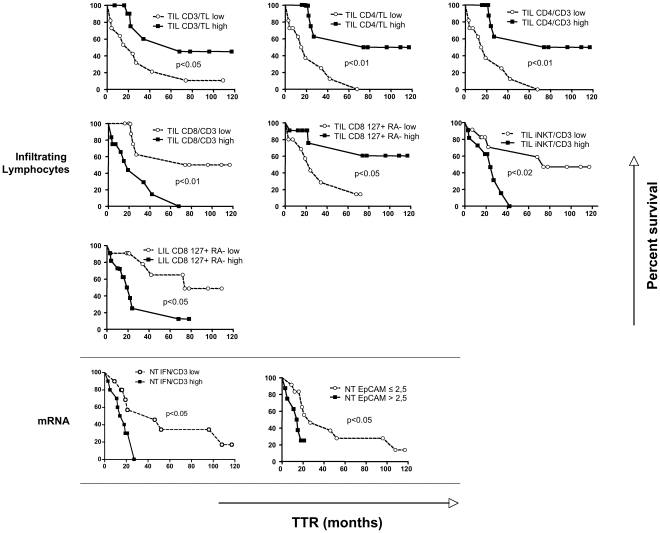
Kaplan-Meier curves of time to recurrence (TTR) among HCC patients.Prognostic significance of the frequency of tumor (TIL) or nontumorous liver infiltrating lymphocytes (LIL) are shown in the upper part of the figure. mRNA expression in nontumourus liver of IFN-γ and EpCAM is shown in the lower part of the figure. A specific cut-off (above or below 2.5-fold reference normal liver) was applied to EpCAM mRNA. TL: total lymphocytes; low, high: lower or higher than median value. P values were determined by the log-rank test.